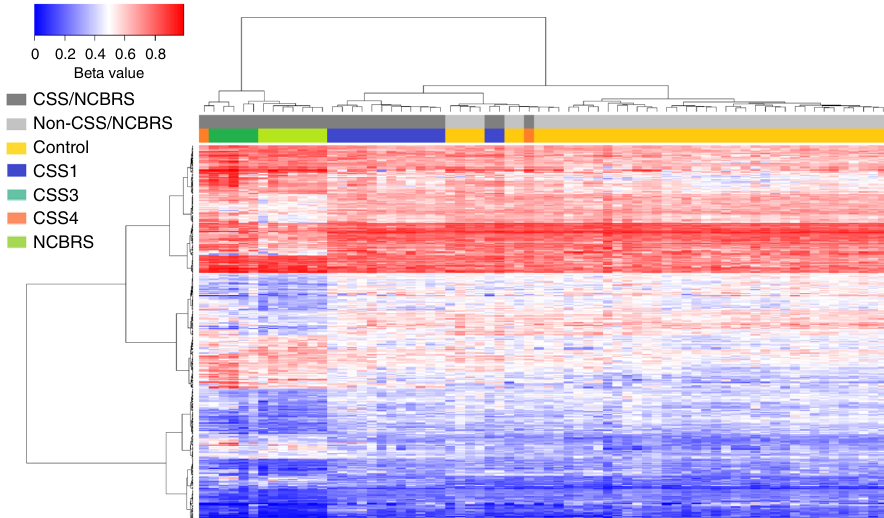
Fig. 2 Clustering analysis using the probes identi fi ed for NCBRS. Clustering analysis was performed using Ward ’ s method on Euclidian distance. Rows represent the CpG probes, and columns represent the subjects. The color scale from dark blue to dark red represents the range of the methylation levels (beta values) between 0 and 1. The top pane represents the overall status of the condition, i.e., CSS/NCBRS vs. non-CSS/NCBRS. The lower pane indicates the subtype for every sample including CSS1 (dark blue), CSS3 (dark green), CSS4 (orange), NCBRS (light green), and controls (yellow). Hierarchical clustering of 365 probes differentially methylated between patients with NCBRS selectively groups CSS3 and NCBRS samples into one cluster, but CSS1 and controls into the other. The two CSS4 subjects are split between the two